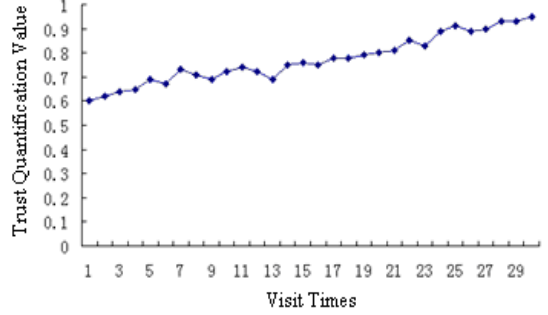
Fig. 5. Change of the trust quantification value for the